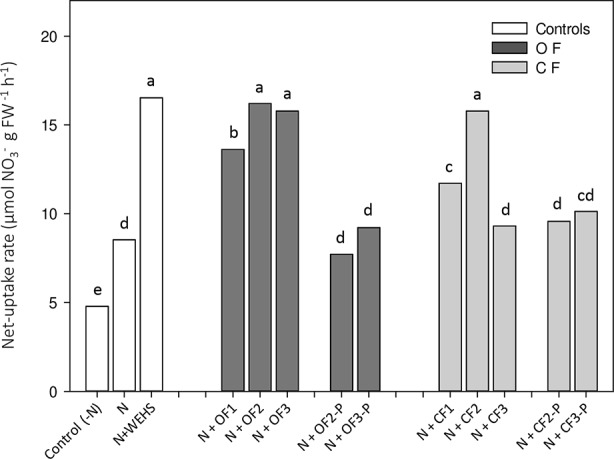
Net uptake rates of nitrate by roots of maize plants exposed for 4 h to humic substances of different origin. White bars, As controls, plants exposed to N-free nutrient solution [Control (-N), or nutrient solution containing nitrate (0.5 mM Ca(NO3)2) with or without water-extractable humic substances (WEHS) (5 mg Corg L−1; N+WEHS or N, respectively). Dark gray bars, Plants exposed to nutrient solution with nitrate and dissolved humic substances (DHS) (5 mg Corg L−1) isolated from organic farming (OF) soils. Light gray bars, Plants exposed to nutrient solution with nitrate and DHS (5 mg Corg L−1) isolated from conventional farming (CF) soils. The code name of samples is reported in Figure 1. Bars with the same letters are not significantly different at p ≤ 0.05.